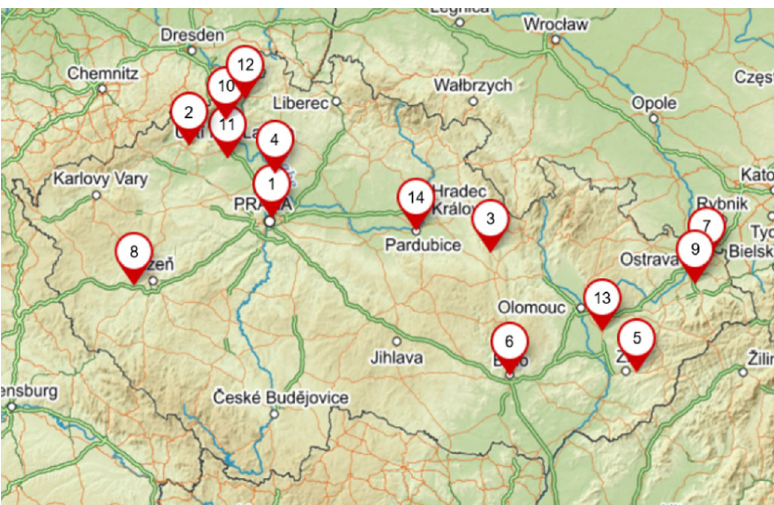
Figure 3: Location of container transshipment terminals in the Czech Republic [ 8 ] . ( 1 ) Praha Uh ř ín ě ves, ( 2 ) Obrnice, ( 3 ) Č eská T ř ebová, ( 4 ) M ě lník ( t ř i p ř ekladi š t ě ) , ( 5 ) Ž elechovice nad D ř evnicí – Lípa, ( 6 ) Brno, ( 7 ) Š enov, ( 8 ) Ný ř any, ( 9 ) Paskov, ( 10 ) Ústí nad Labem, ( 11 ) Lovosice, ( 12 ) D ěč ín – Loubí, ( 13 ) P ř erov, and ( 14 ) Pardubice – Č erná za